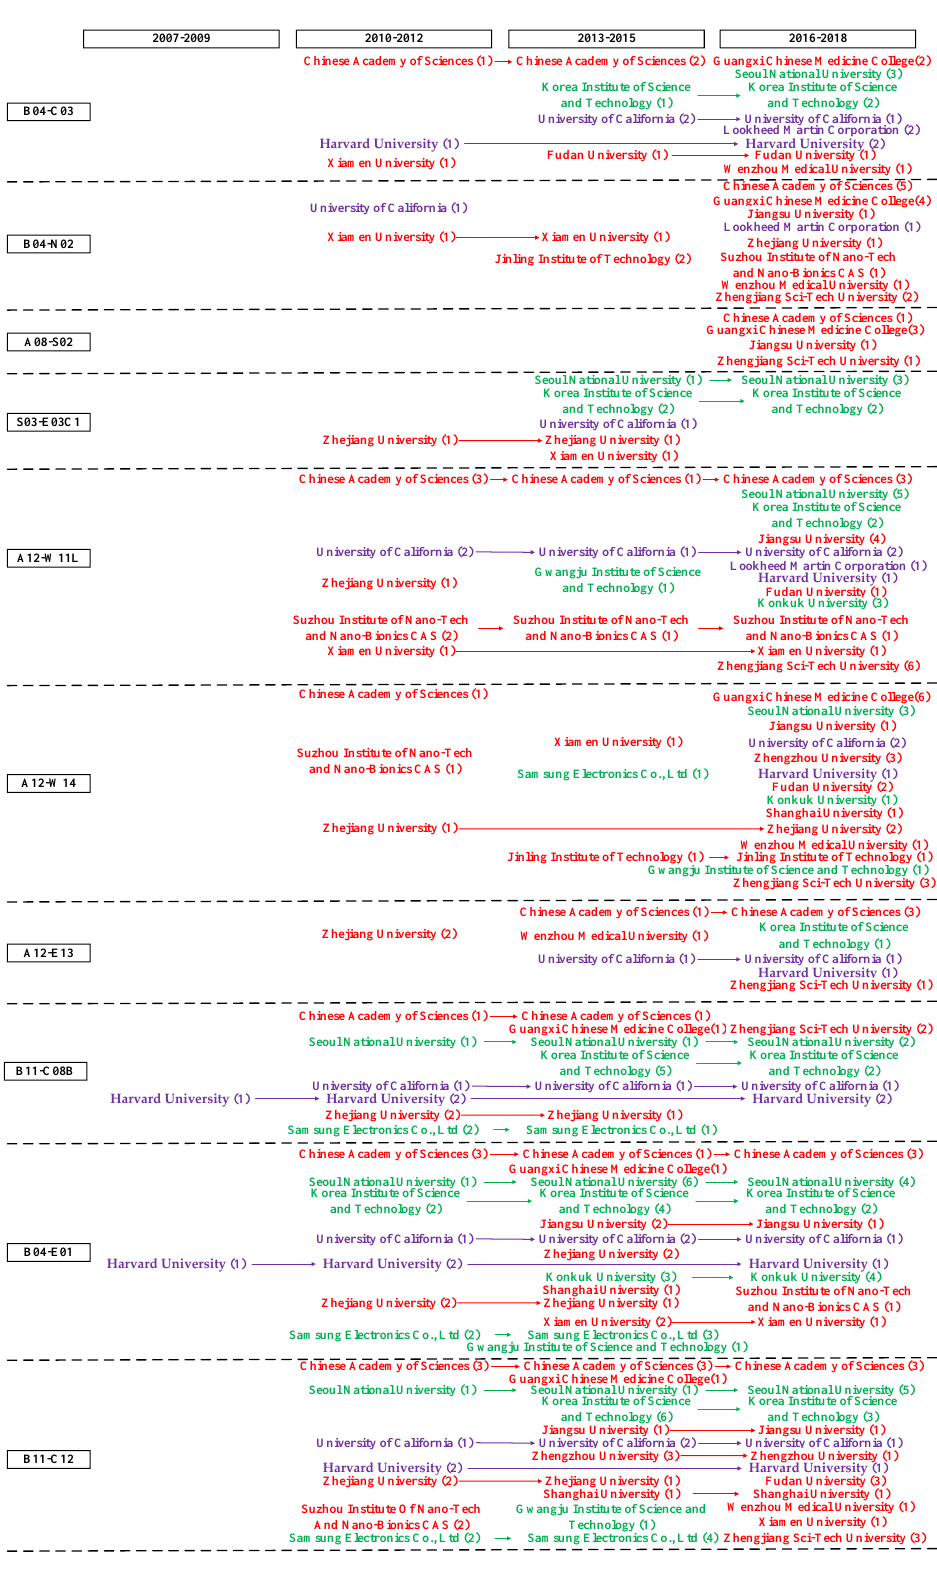
Figure 5. Assignee level patent roadmap of graphene biomedical technology. The process of patent roadmap mainly includes four stages. First, we decide the horizontal axis and vertical axis. Specifically, the horizontal axis represents the time-line. We separate the period from 2007 to 2018 into five three-year periods, because the patent application among the top 20